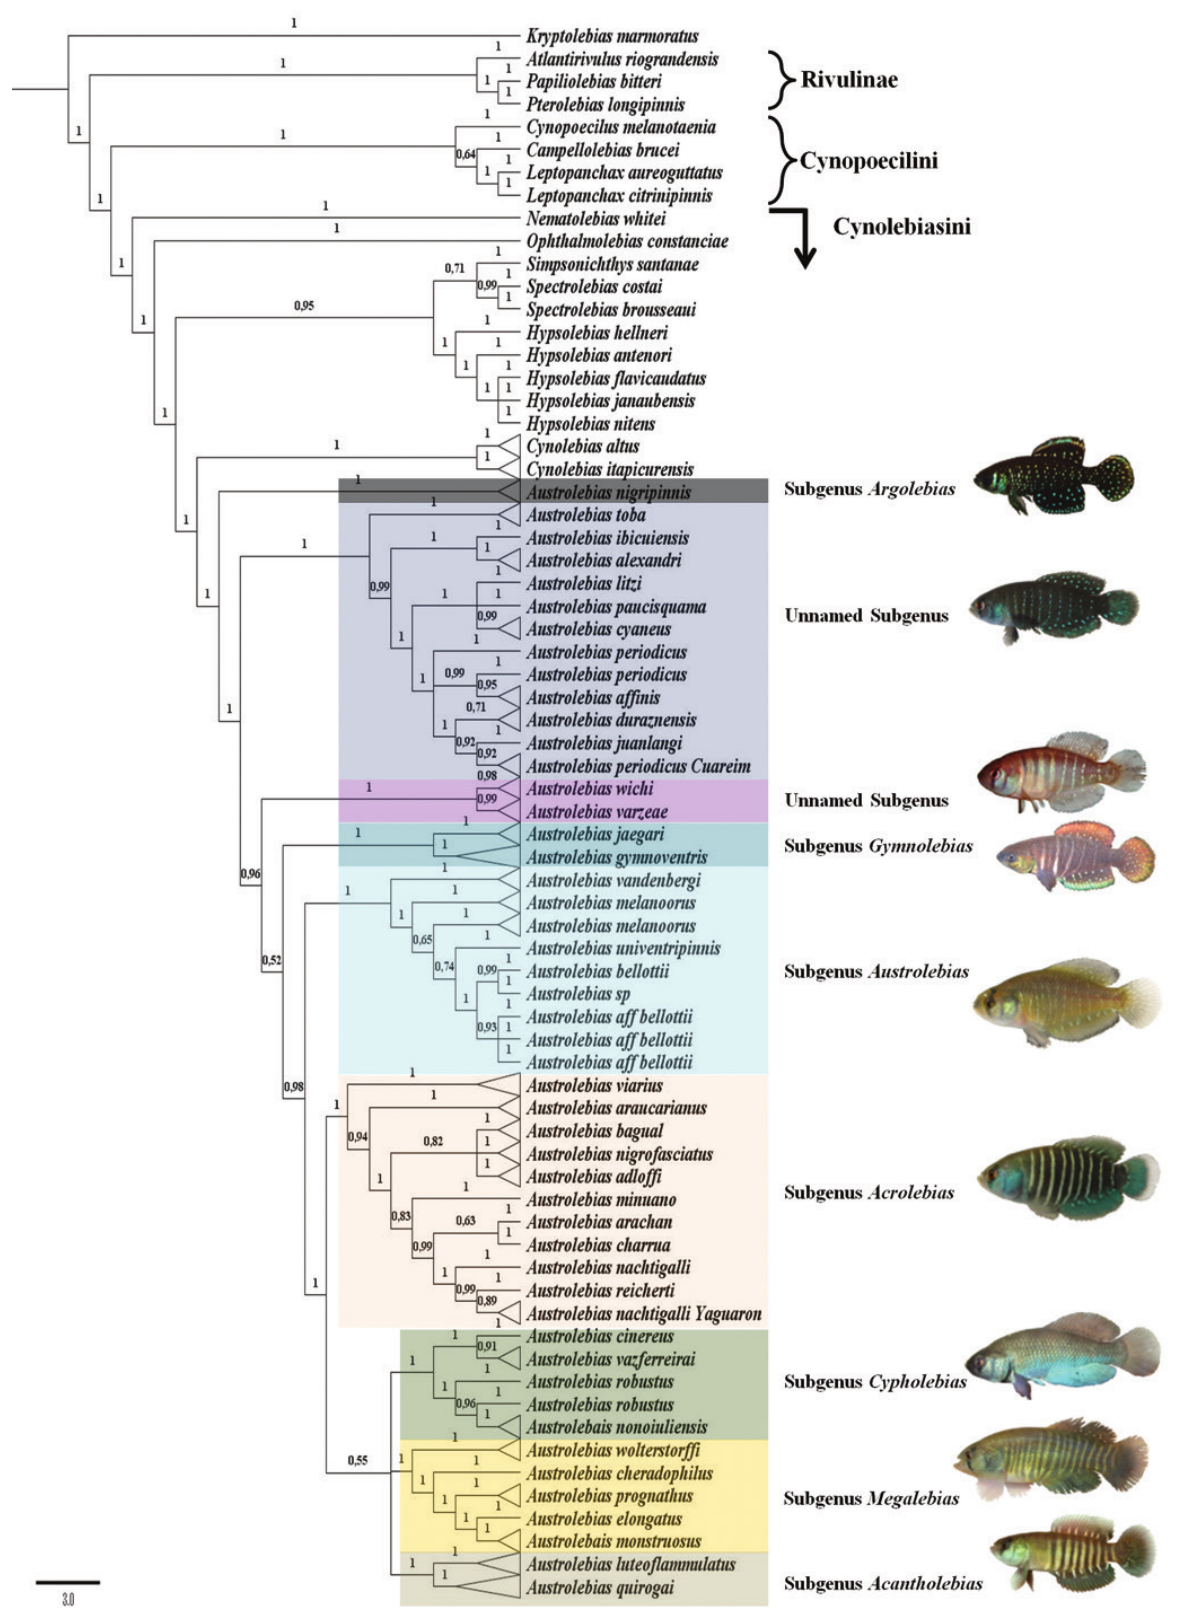
Fig. 12. Bayesian phylogenetic tree of Austrolebias , based on molecular (ribosomal unit 16s, Cytochrome b, RAG1, Glyt) and morphological characters. Values above branches are posterior